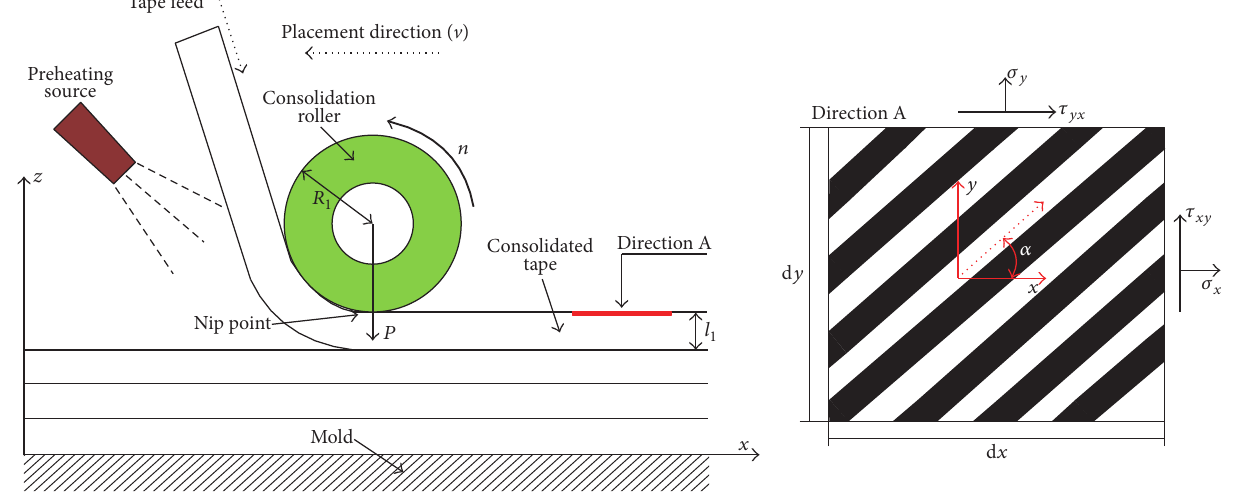
Figure 1: High-speed preheating AFP process and a feature